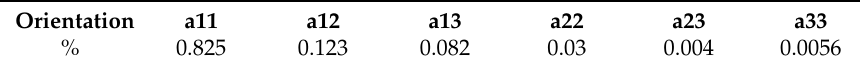
Table 2. Fiber orientation distribution of printed CFRP-Nylon